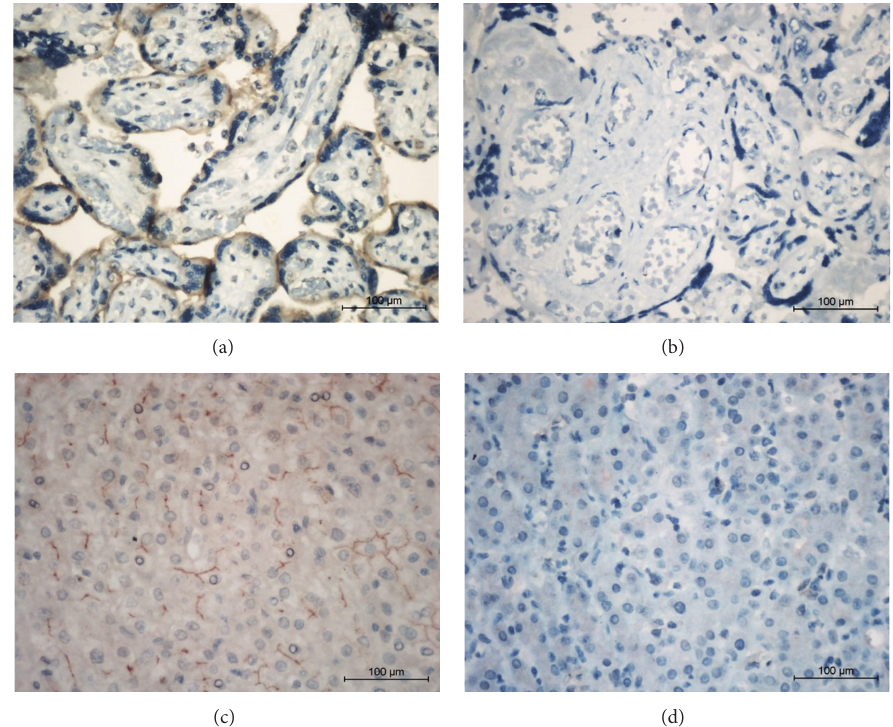
Figure 1: Expression of ABCG2 in human HCC tissues. (a) ABCG2 was expressed in placenta tissues (positive control). (b) Primary antibody omitted placenta tissue slide was set as negative control. (c) Positive ABCG2 expression in HCC tissue. (d) Negative ABCG2 expression in HCC